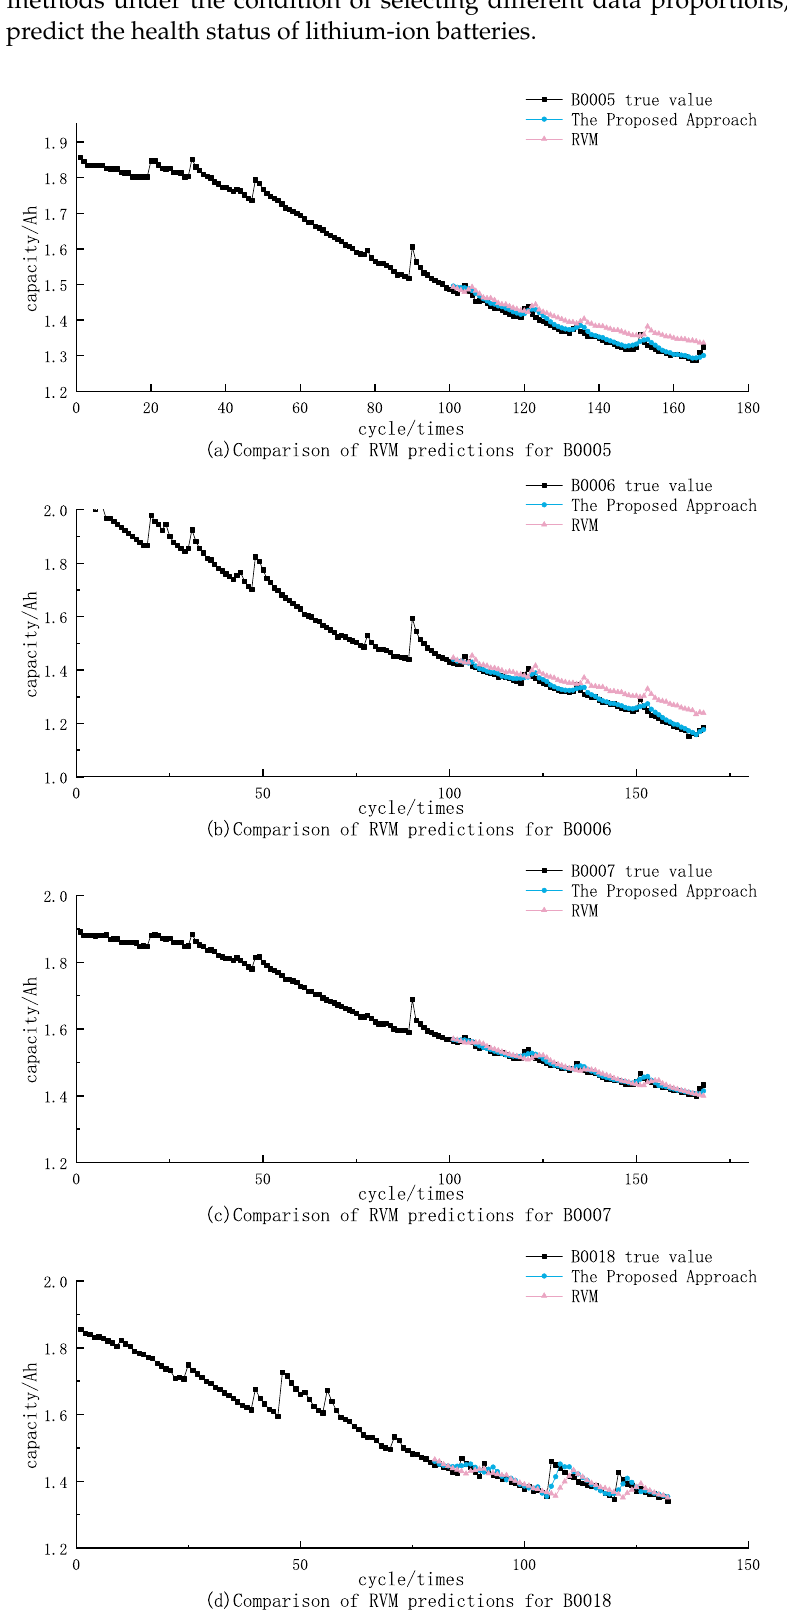
Figure 8. Comparison of the proposed method with RVM